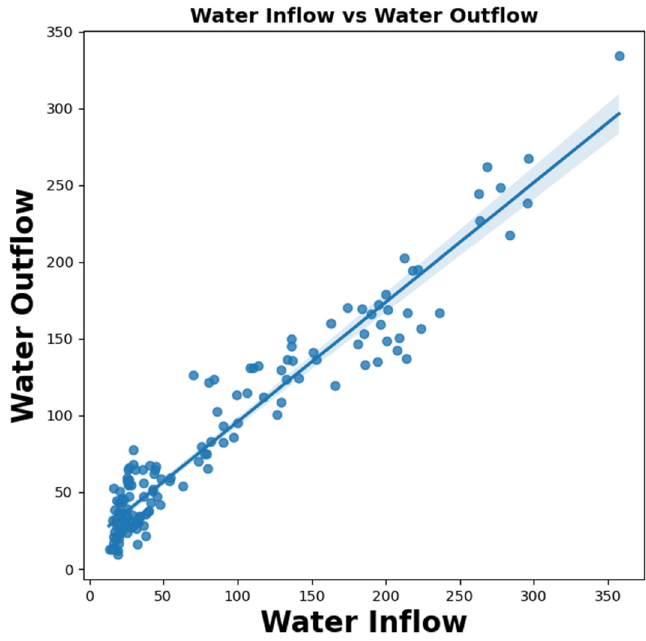
Figure 10. Regression Plot between water inflow and water outflow.